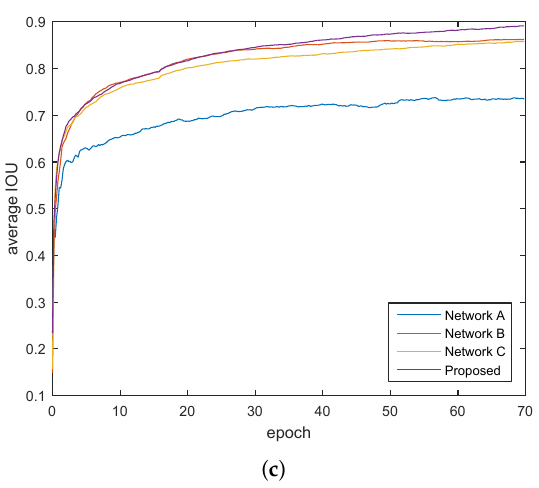
Figure 6. Training average Accuracy/epoch, Recall/epoch and IOU/epoch curve of networks with different multi-scale structure in Figure 5, with ( a - c ) labeled accordingly.